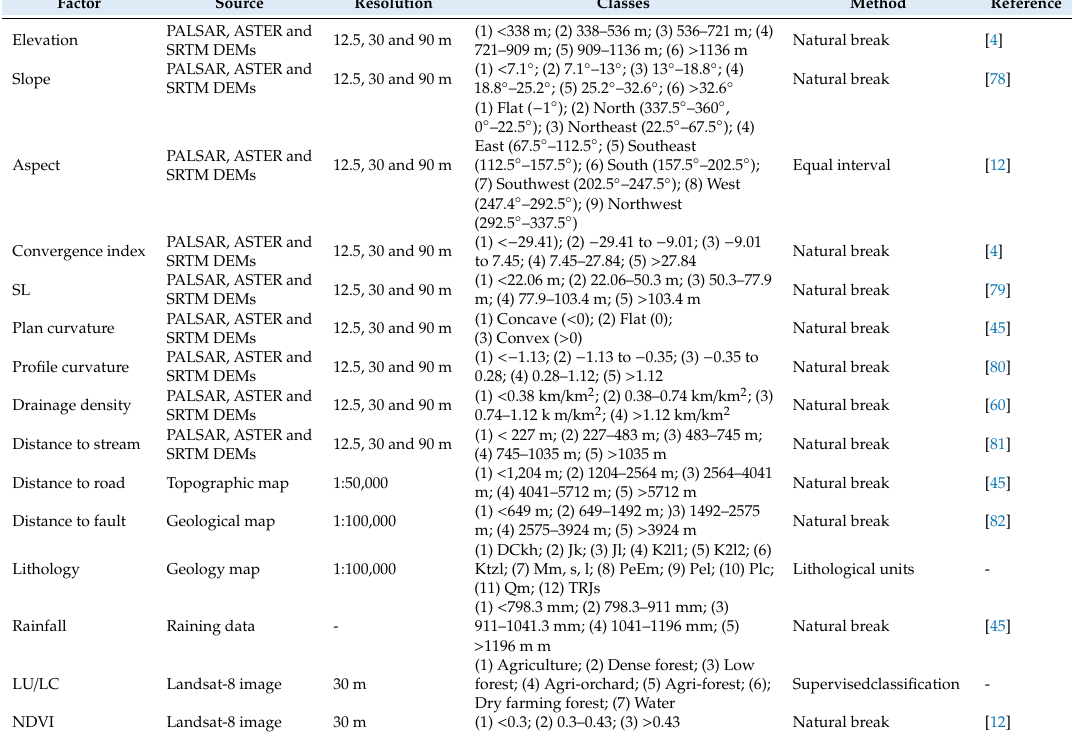
Table 2. Overview of factors used for landslide susceptibility mapping